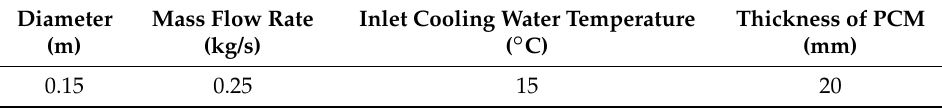
Table 3. Baseline case of PV/T